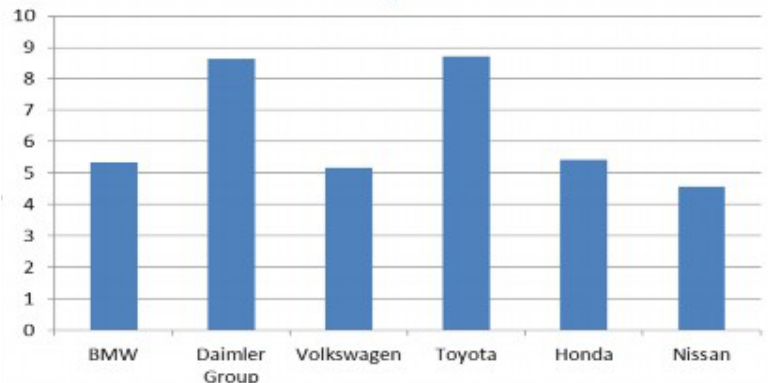
Fig. 1.Investment in R&D of automobile companies in percent of proceeds. Average value of the ratio for the last 10 years